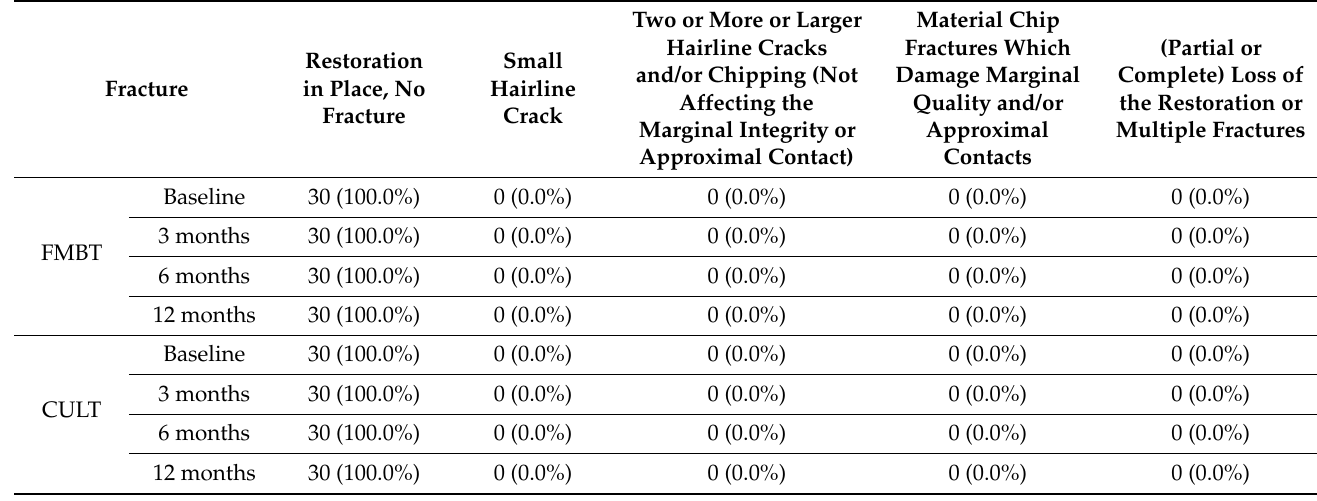
Table 5. Fracture of restored teeth with FMBT and CULT over time ( p > 0.05).